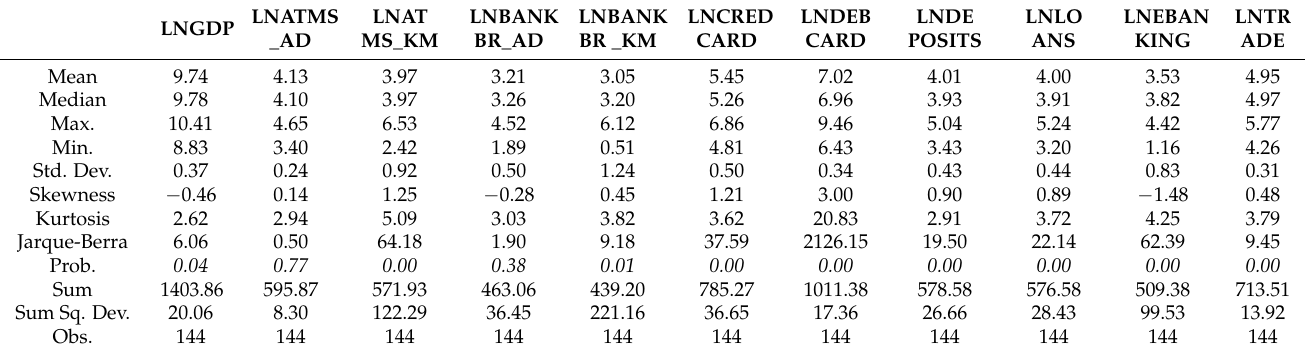
Table 3. Descriptive statistics of the variables in CEE countries.